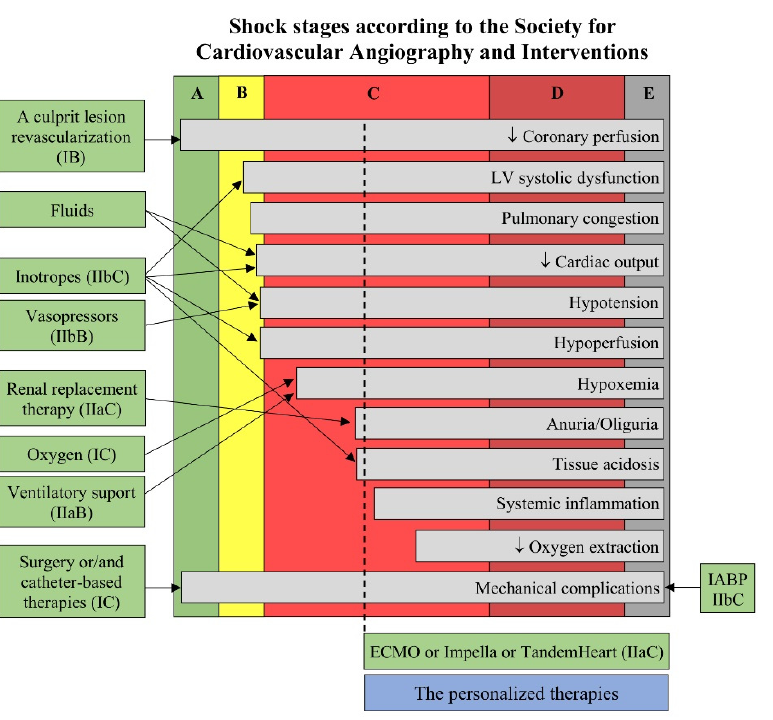
Figure 2. Current treatment of cardiogenic shock tailored to its stage. The available therapeutic methods with their classes of recommendation according to the European Society of Cardiology [12] have been assigned to pathological processes within the A to E stages of cardiogenic shock [20]. The personalized, innovative solutions are particularly expected in the higher stages of cardiogenic shock. Abbreviations: IABP: intra-aortic balloon pump, ECMO: extracorporeal membrane oxygenation.